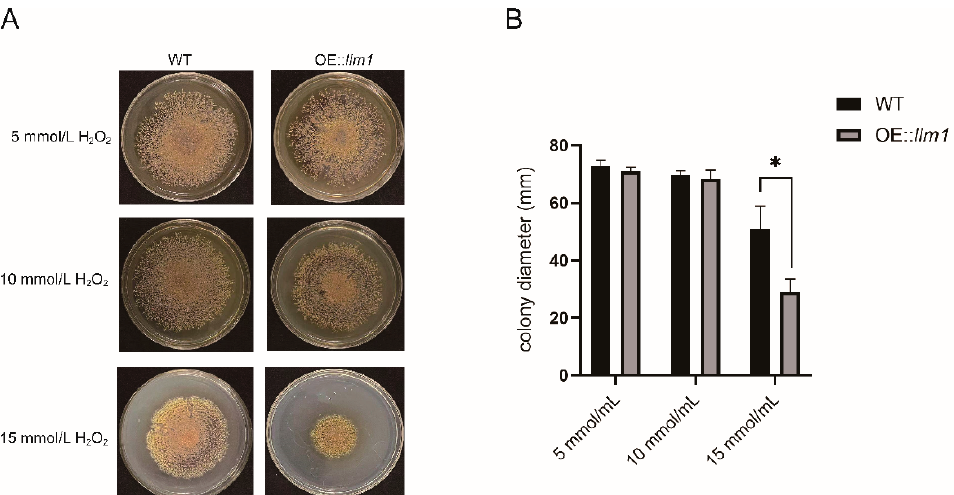
Figure 3. Phenotypes of WT and OE:: llm1 transformant under different concentrations of hydrogen peroxide. Growth ( A ) and colony diameter ( B ) were measured under different concentrations of hydrogen peroxide. Experiments were conducted in three replicates. Standard deviations are indicated with error bars. Values that differed significantly from the value for the WT according to the t -test are indicated with asterisks (* p < 0.05).